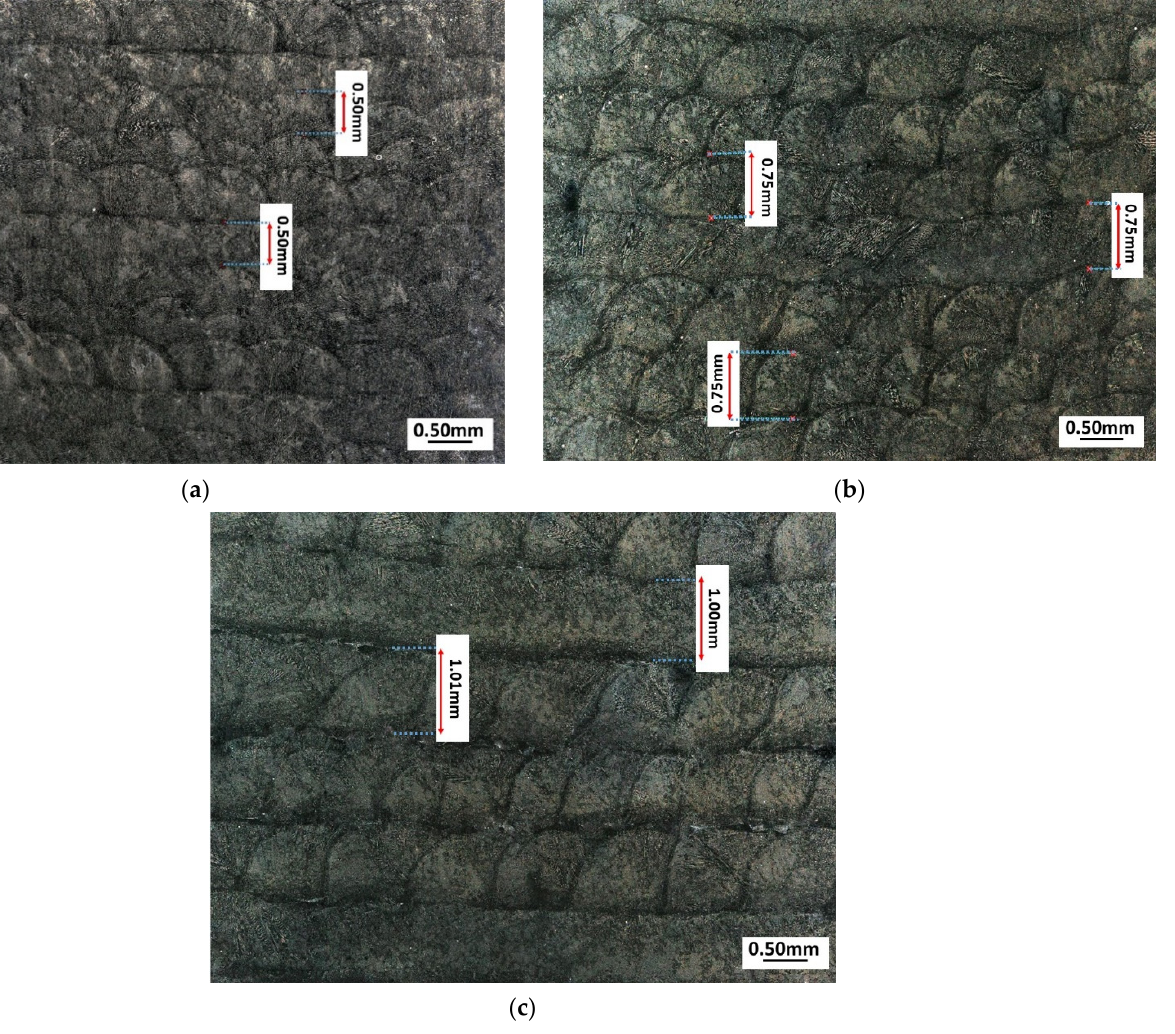
Figure 5. Microstructure of ( a ) sample A (layer thickness—0.5 mm); ( b ) sample B (layer thickness— 0.75 mm); ( c ) sample C (layer thickness—1 mm).